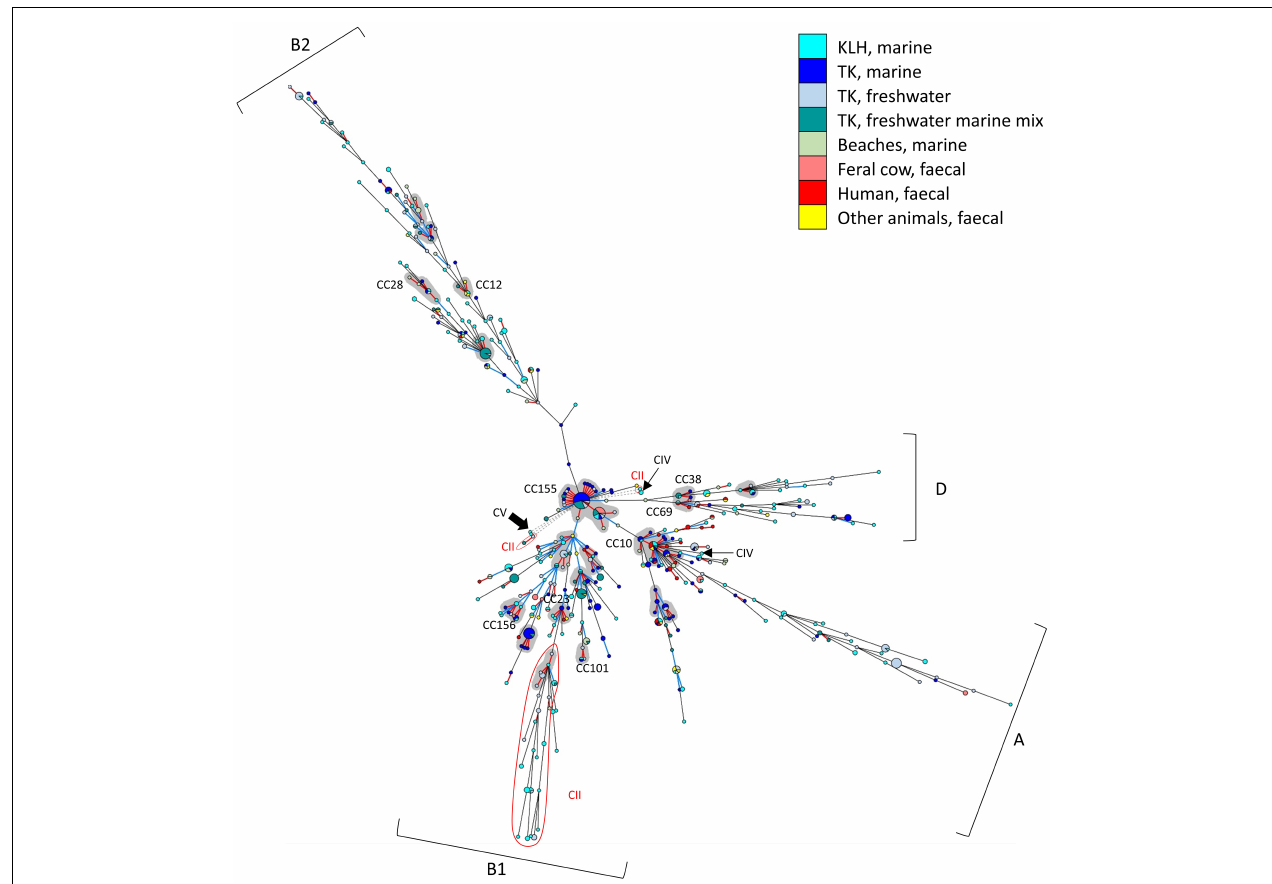
FIGURE 3 | Minimum spanning tree (MST) displaying the genetic relatedness of the 708 isolates. Each node represented one ST. Node size is proportionate to the number of isolates contained in the node. Branch length is proportionate to distance between nodes, with red branch denoted 1 locus difference; blue: 2 loci; black: 3–6 loci; and gray dashed branch: no loci in common. CCs were shaded with gray background and nine well-established E. coli CCs that could also be identified in this study were labeled. E. coli phylogroups (A,B1,B2,D) for majority of the STs in each of the four main branches were indicated. The cryptic clade II STs were highlighted and indicated with red fonts; clade IV STs were indicated with thin black arrows; and a thick arrow indicated the sole clade V in this study.